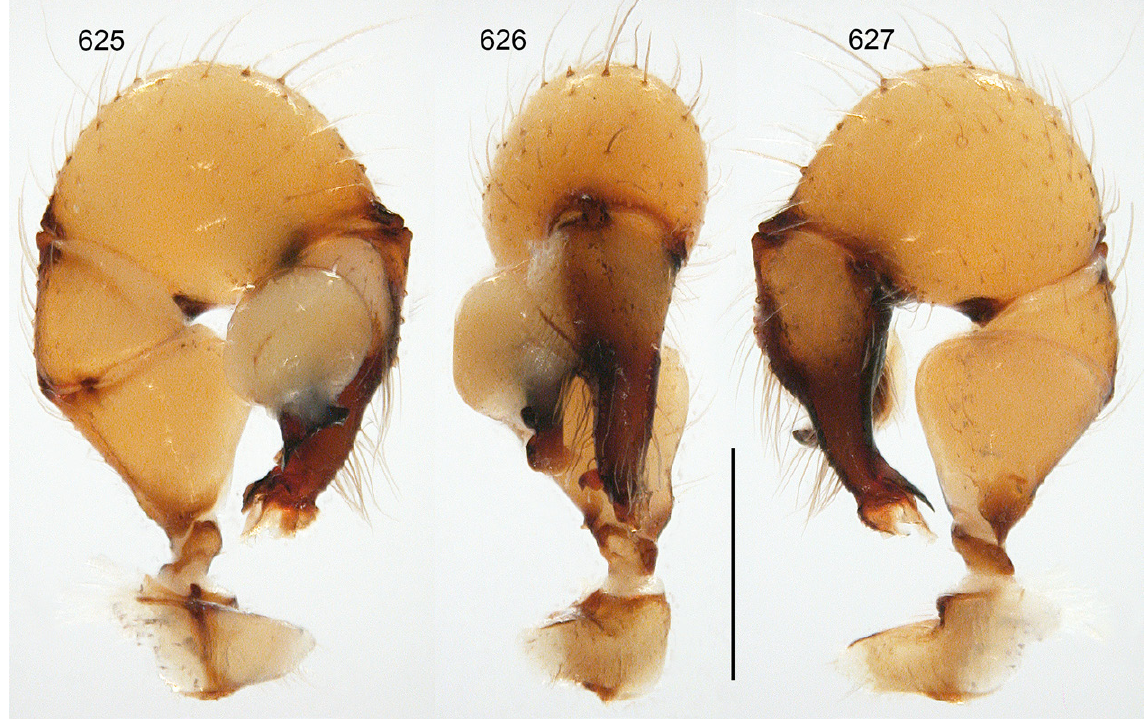
Figs 625–627. Crossopriza manakhah sp. nov.; male from Yemen, 12 km NW of Manakhah (ZFMK Ar 22441); left palp, prolateral, dorsal, and retrolateral views. Scale bar = 0.5